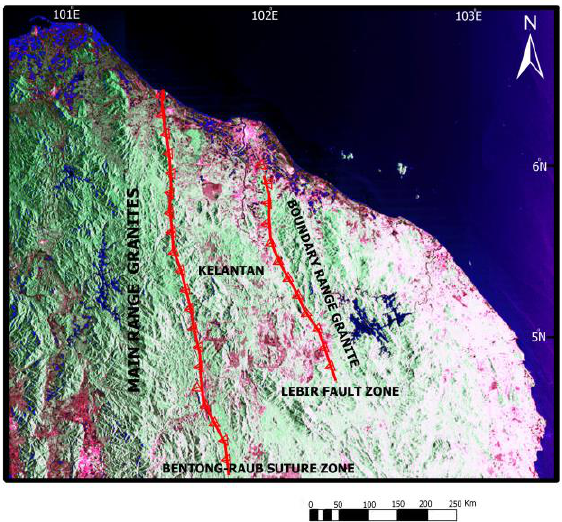
Figure 2. RGB colour combination (HH, HV and HH+HV polarization channels) of PALSAR-2 Scan SAR scene covering northern part of the Peninsular Malaysia.